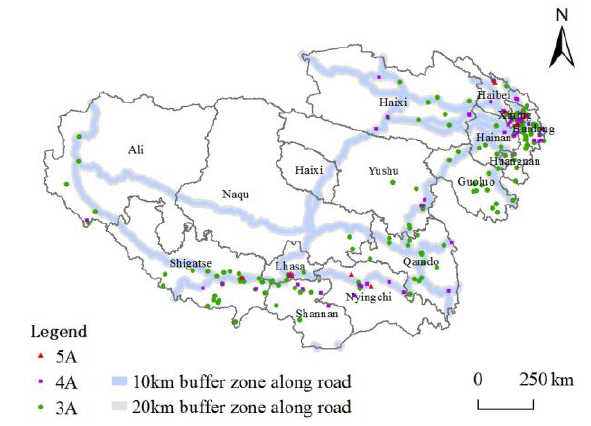
Figure 9. Spatial distribution of tourist attractions and roads.